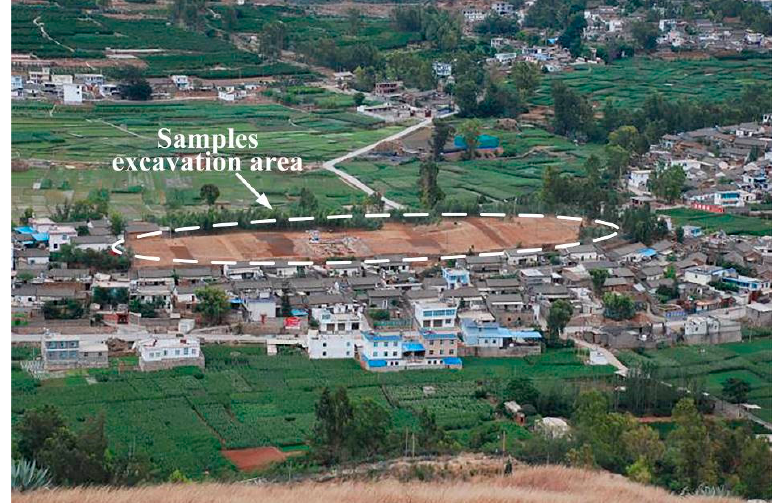
Figure 2. Aerial view of the Yubeidi site.